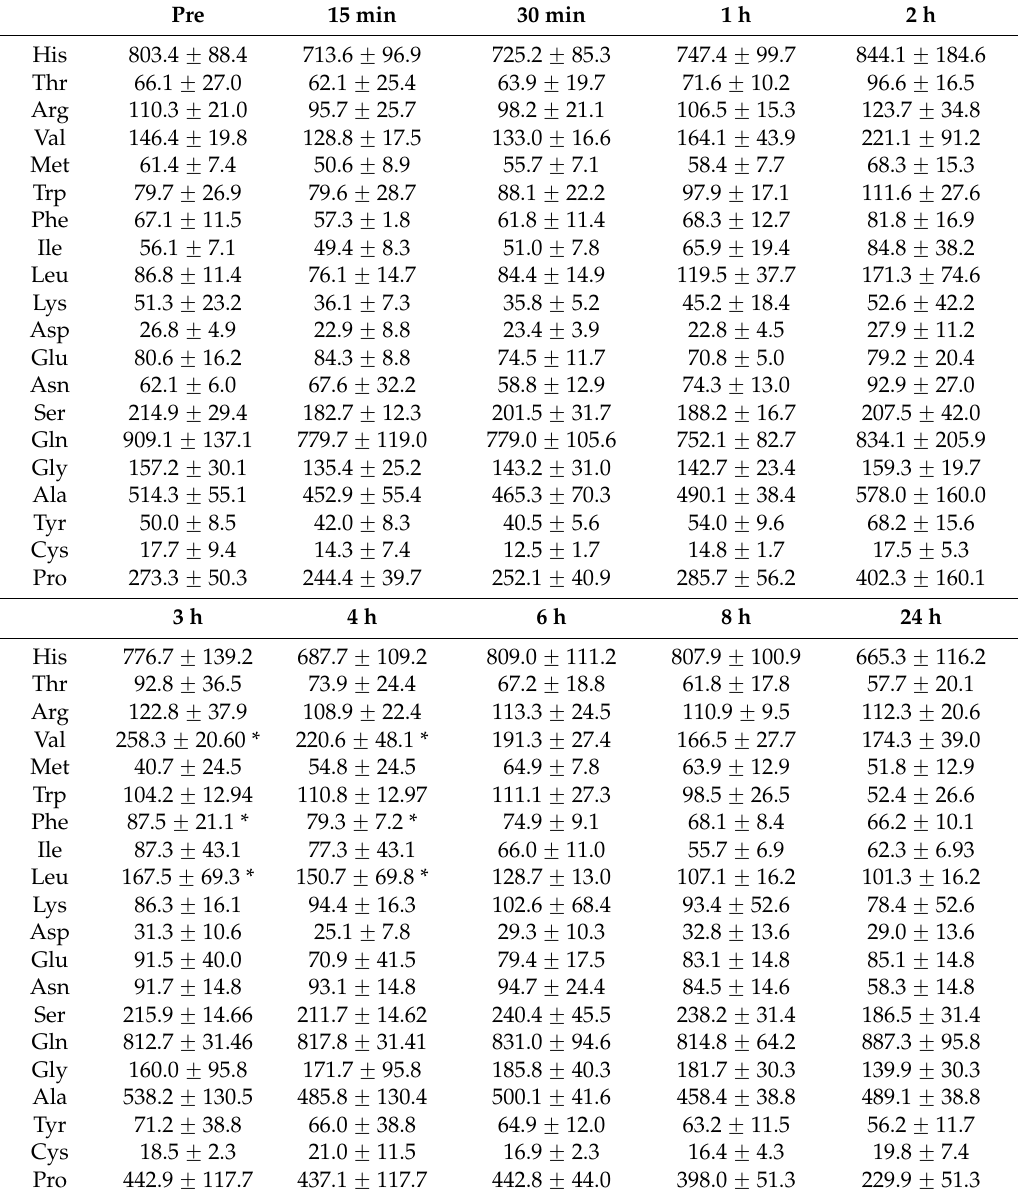
Table 2. PFAA concentrations before (Pre) and at indicated times after food